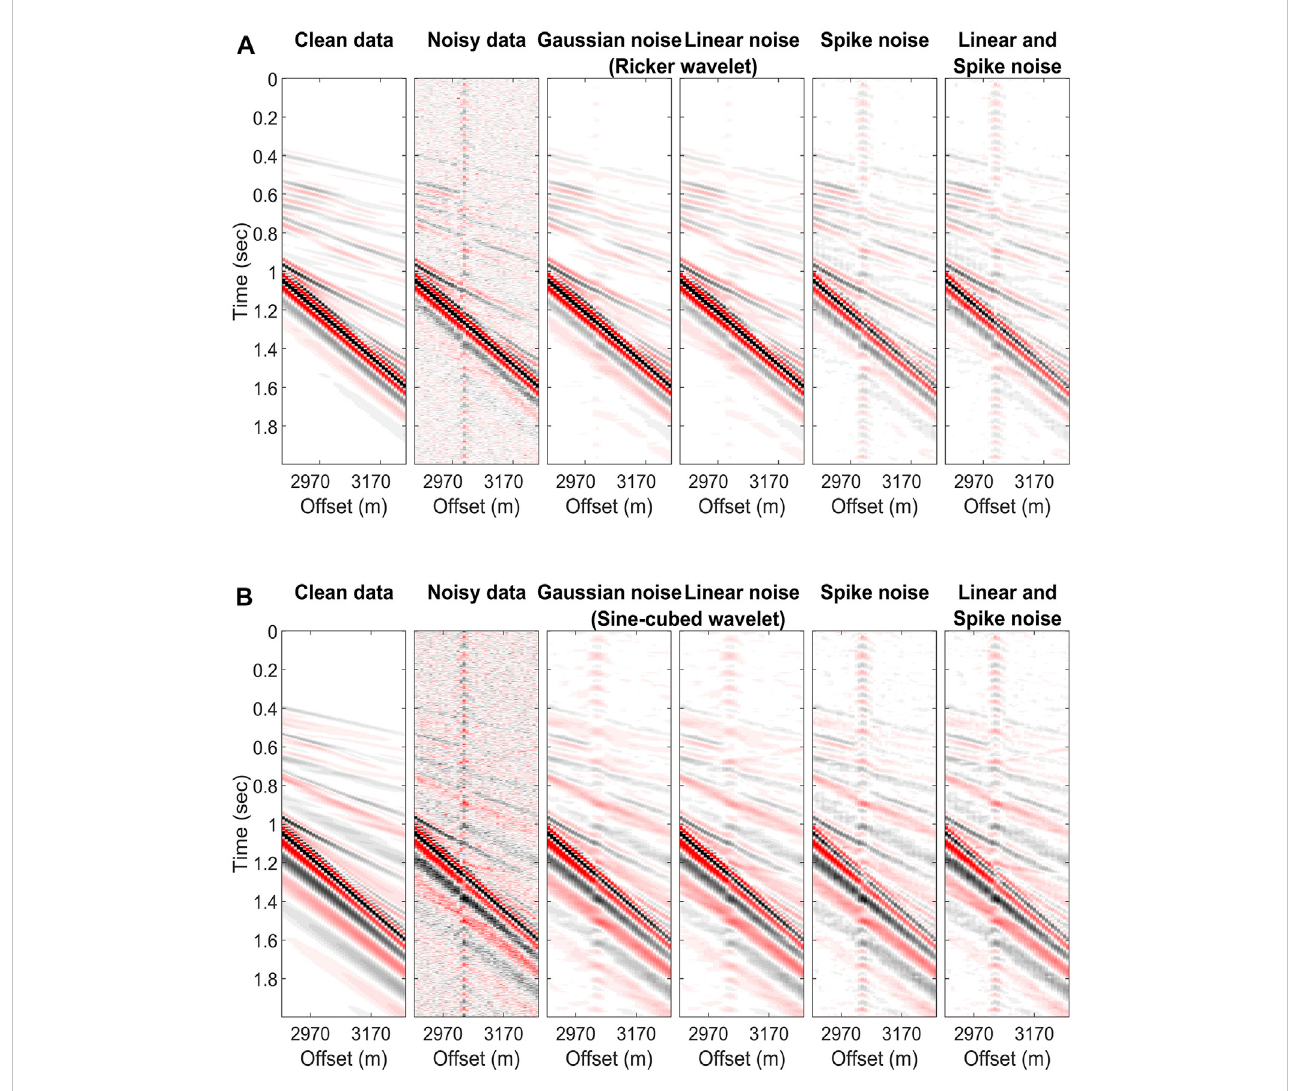
FIGURE 8 Limitationtestresultswiththreedifferentnoisetypesandtwosourcewavelets,includingthe (A) Rickerwaveletand (B) sine-cubedwavelet.Thezoomed denoised results are located in the magenta boxes in Figure 7.